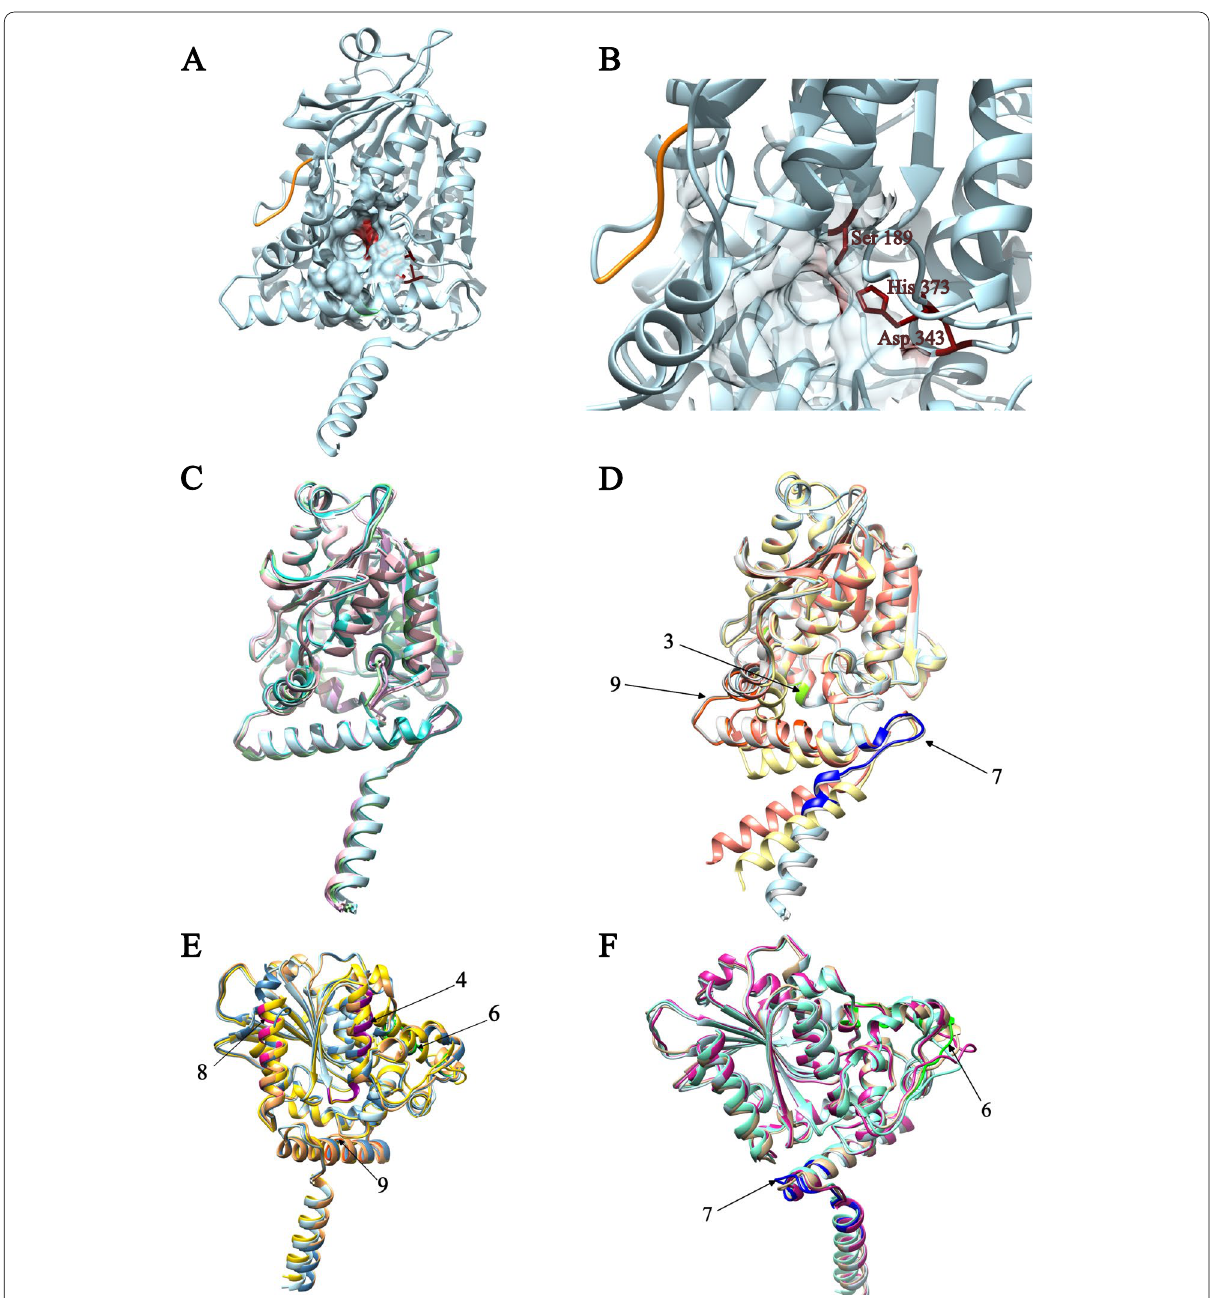
Fig. 6 Tridimensional structural comparison of AADAC from orthologues. A ADDAC from Homo sapiens , the active site is shown in red, and the YXLXP motif in orange. B Active site of AADAC from Homo sapiens . The catalytic amino acids are represented by sticks. C Structural alignment of representative organisms from mammals ( Macaca mulata in aqua), amphibian ( Nanorana parkeri in pink), birds ( Anas platyrhynchos in purple), reptiles ( Trachemys scripta elegans in light green). D Structural alignment of mammalian AADAC showcasing the motif differences ( Condylura cristata in grey color , Urocitellus parryii in salmon color and Marmota flaviventris in yellow color). E Structural alignment of birds ( Camarhynchus parvulus in gold color, Gallus gallus in steel blue and Egretta garzetta in brown). F Structural alignment of amphibian and reptile organisms with motif differences ( Amblyraja radiata in pink, Geotrypetes seraphini in aquamarine and Gekko japonicus in beige). The numbers indicate the structural motif related to MEME suite analysis (Fig.